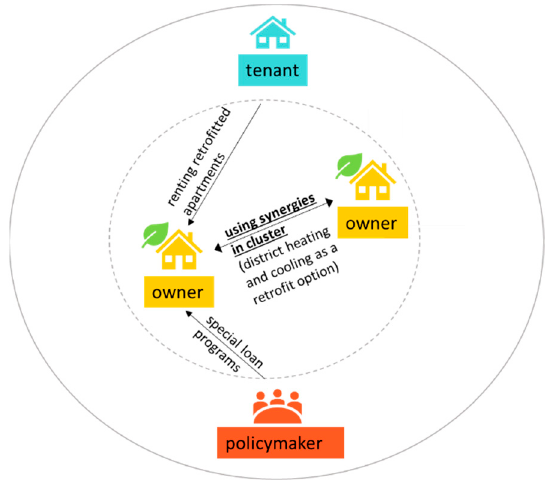
Figure 7. Energy conservation investment community use-case. Dashed line denotes the community.